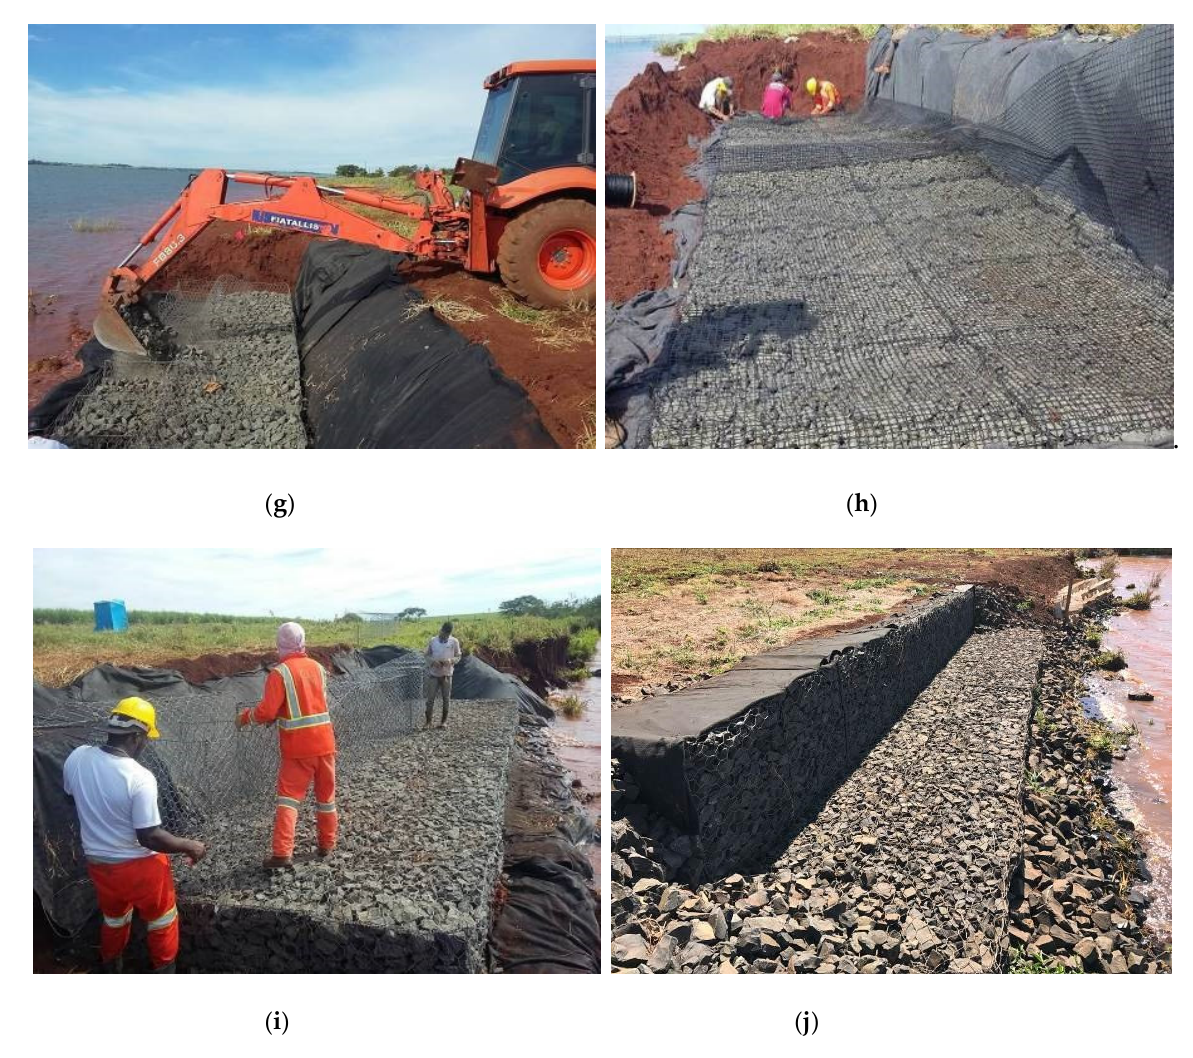
Figure A. General installation procedures of the techniques: ( a ) mechanical reshaping of the margins, ( b ) manual reshaping of the margins, ( c ) installation of the geotextile, ( d ) transportation of boxes to make the mattress, ( e ) installation of the metallic mesh/geogrid on the geotextile, ( f ) installation of the mattress boxes ( g ) mattress box filling, ( h ) closing the mattress covers, ( i ) installation of the gabion on the mattress and ( j ) final installation.